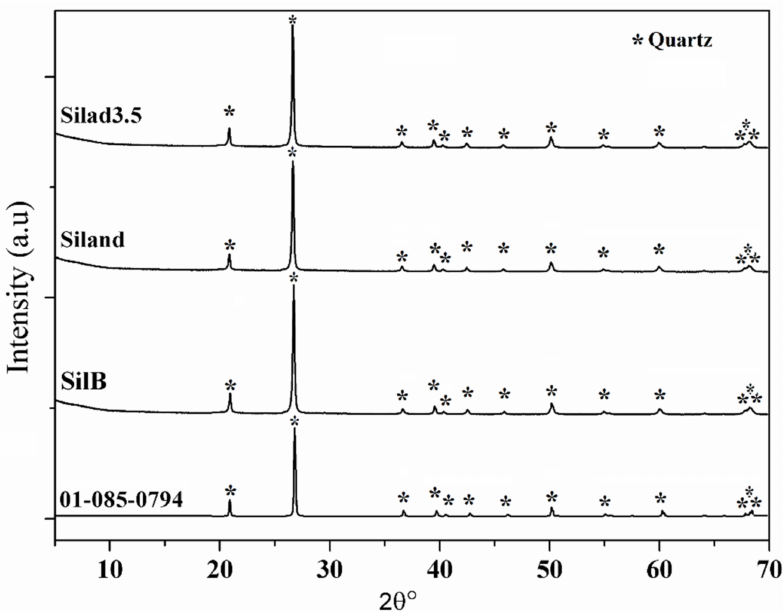
Figure 9. XRD patterns of SilB, Siland, and Silad3.5